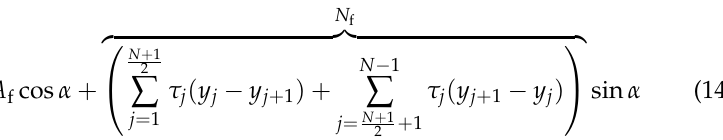
Figure 5. Pressure and shear stress applied on an airfoil surface.